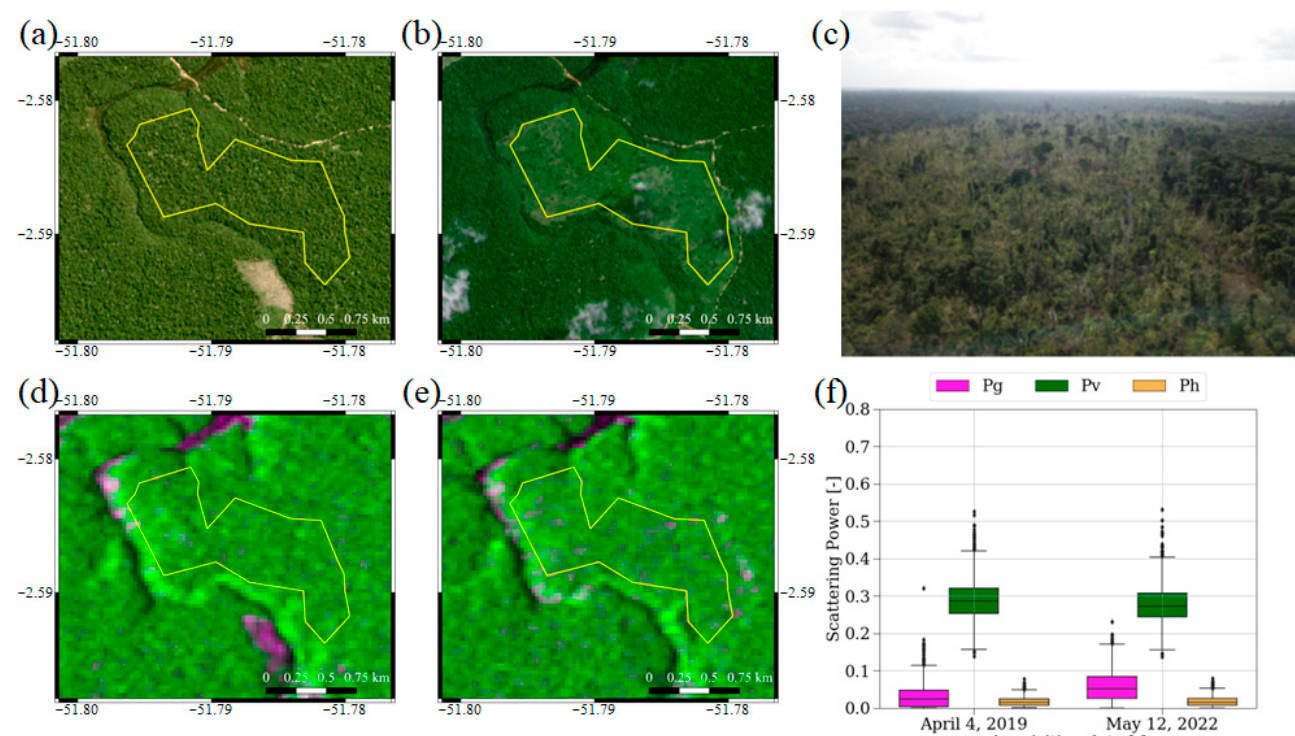
Figure 9. Forest degradation at Altamira not detected by using the proposed method with actual dual-polarization data acquired on 4 April 2019 and 12 May 2022. The yellow outline shows the deforestation area based on visual interpretation of Planet/Dove mosaic images. ( a – f ) Same as in Figure 8.